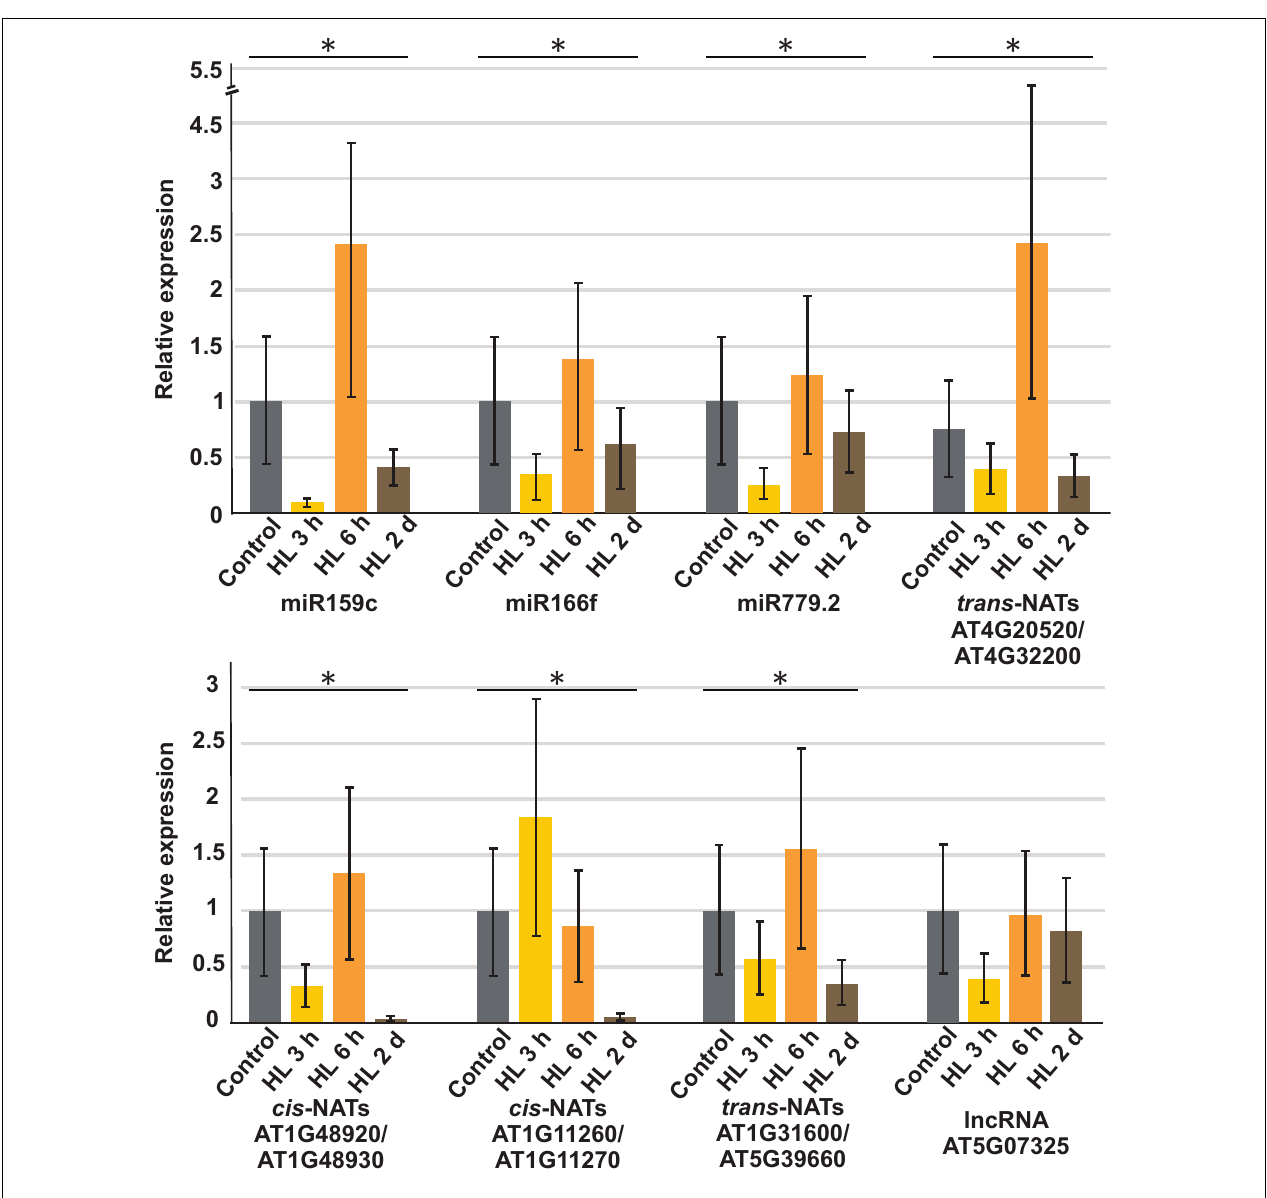
FIGURE 3 | Stem loop qRT-PCR based validation of sRNA sequencing data for miRNAs as well as sRNAs derived from trans -NATs, cis -NATs and lncRNA. Expression values are normalized to UBI1 housekeeping gene and the untreated control was set to 1. The error bars indicate the standard deviation ( n = 3). Statistically significant differences for each sRNA were analyzed by one-way ANOVA ( p < 0.05) and represented by an